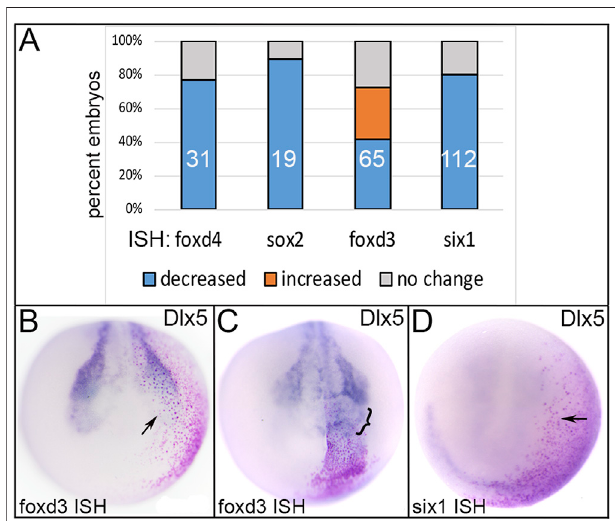
FIGURE 5 | The effects of expressing an Epi-enriched transcription factor, Dlx5, in ectopic domains. (A) The percentage of embryos in which ectopicallyexpressedDlx5reduced(blue)orexpanded(orange)expressionof neural plate ( foxd4, sox2 ), neural crest ( foxd3 ) or PPR ( six1 ) genes. Numbers within the bars denote sample size. (B) Ectopic expression of Dlx5 (Epi TF) in a neural crest precursor blastomere (red dots) reduced expression of foxd3 (NC TF; arrow). Anterior view with dorsal to the top. (C) Ectopic expression of Dlx5 (Epi TF) in a neural plate blastomere (red dots) broadened the expression of foxd3 (NC TF; bracket). Anterior view with dorsal to the top. (D) Ectopicexpression ofDlx5 (Epi TF)inaplacodeprecursorblastomere (red dots)reducedtheexpressionof six1 (PPRTF;arrow).Anteriorviewwithdorsal to the top.